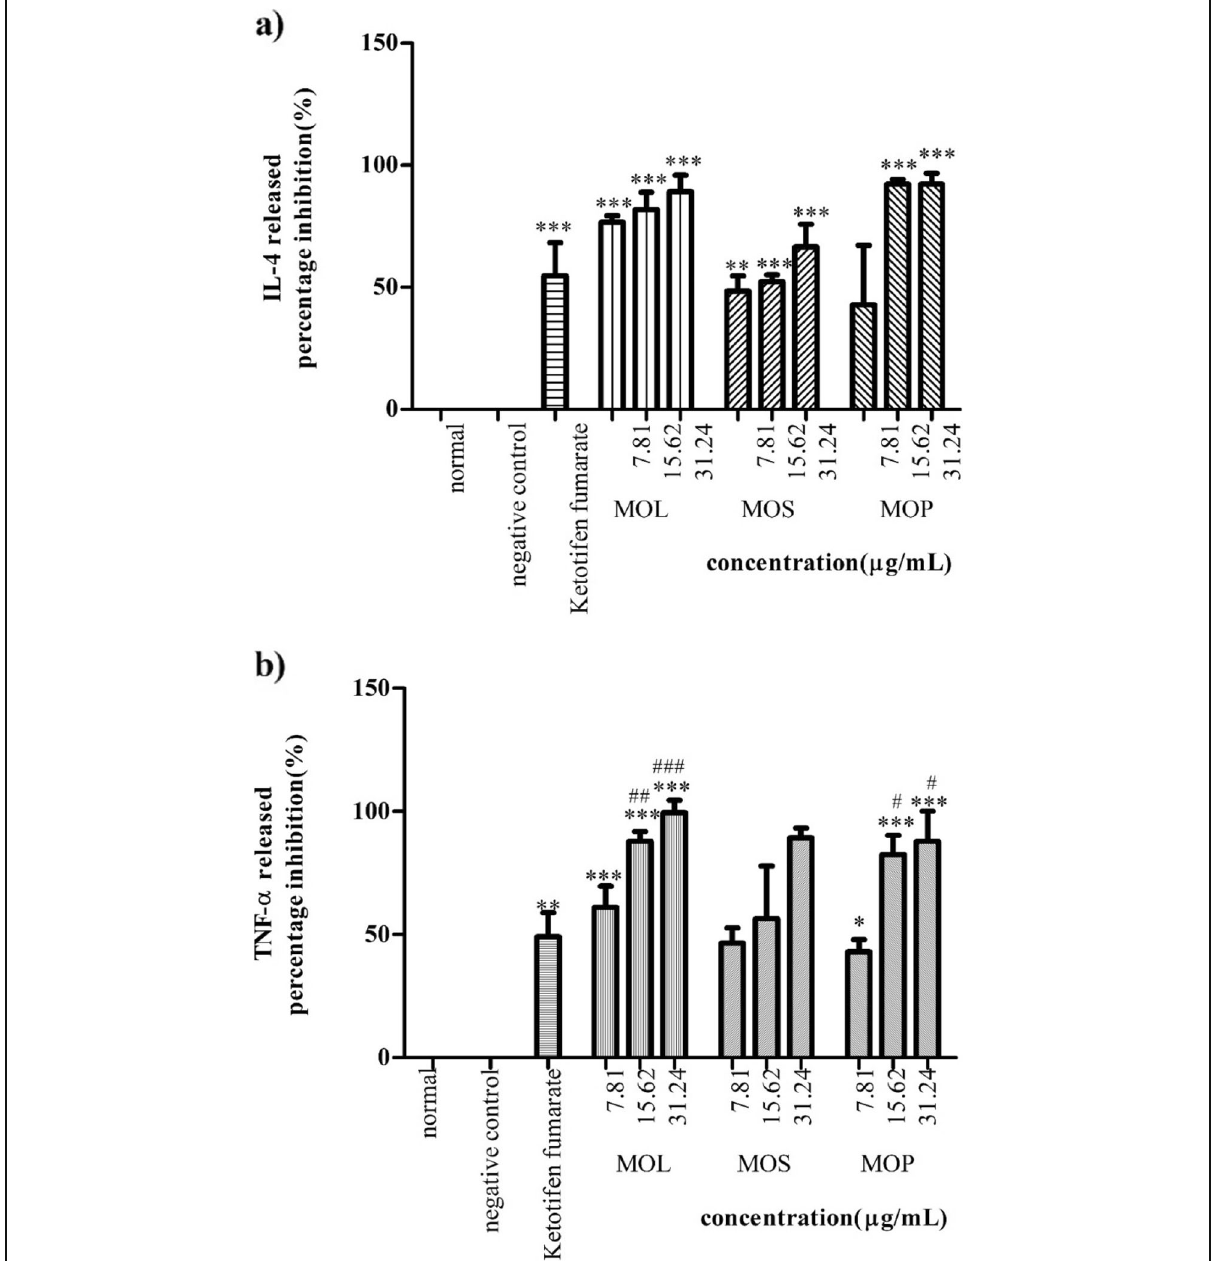
Fig. 5 Percentage inhibition of M. oleifera crude extracts on a ) IL-4 and b ) TNF- α releases. Data are presented as mean ± SEM (n = 3) with significant value of *p < 0.05, **p < 0.01, ***p < 0.001 as compared to positive control and # p < 0.05, ## p < 0.01, ### p < 0.001 as compared to ketotifen fumarate (15.62 μ g/mL). MOL: M. oleifera leaves, MOS: M. oleifera seeds, MOP: M. oleifera